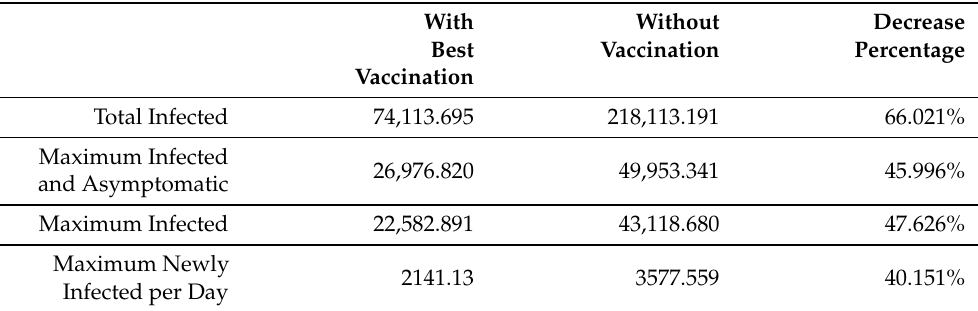
Table 12. Comparison table of infections with and without vaccination.